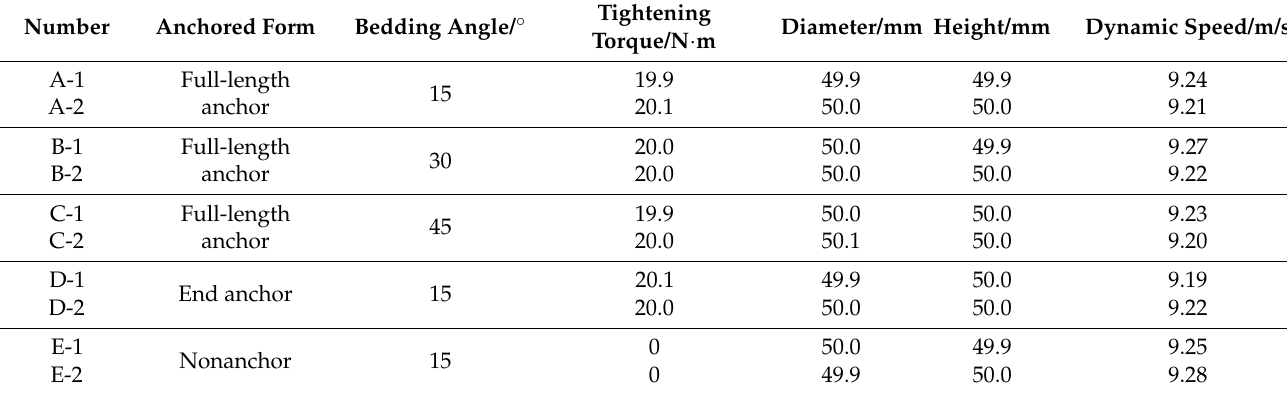
Table 2. Test specimen parameters.